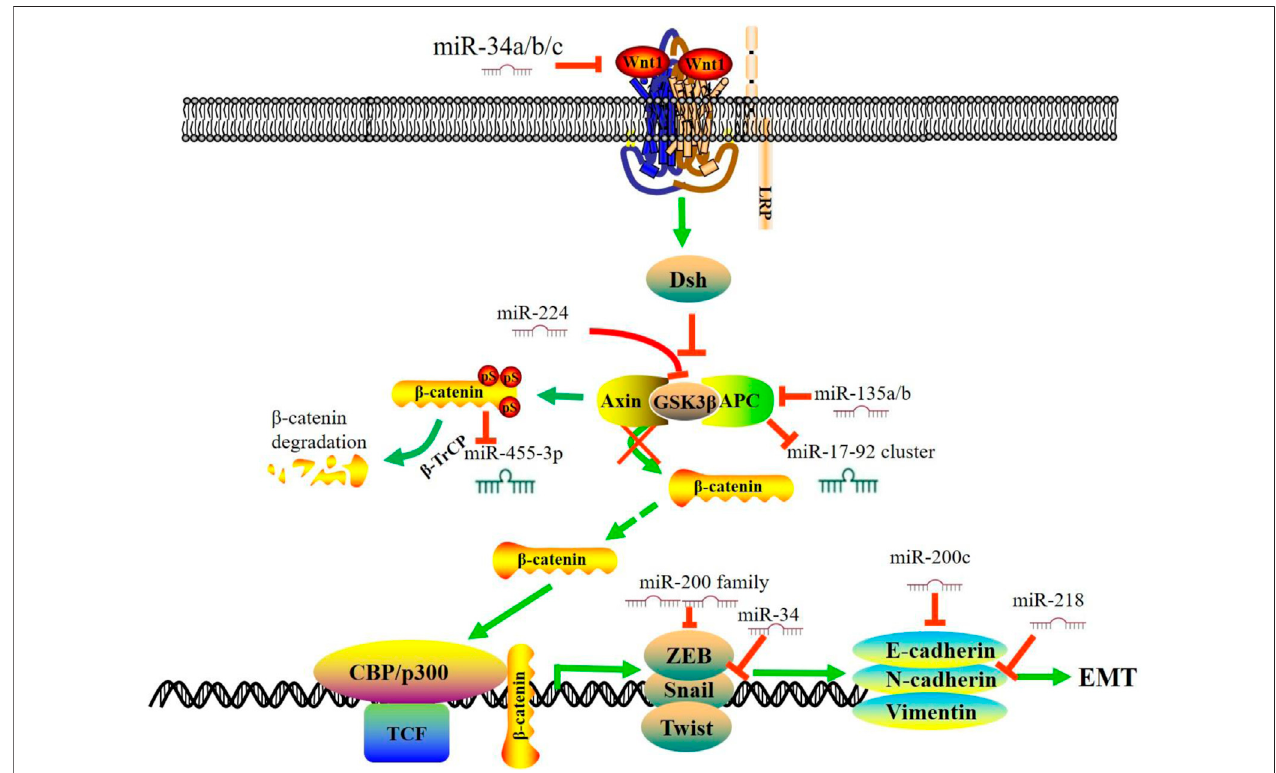
FIGURE1| MiRNAsregulateWnt/ β -catenin signalingpathway andEMTinCRC.IntheabsenceofWnt, β -catenin formsacomplexwithAPC,GSK3andAxin.The β -catenin isphosphorylatedbyGSK3 β andtargetedforubiquitin-dependentproteasomaldegradation. This fi guresummarizestheinteraction betweenmiRNAs andthe Wnt/ β -catenin signaling pathway in CRC and a subset of downstream miRNAs that are involved in the EMT process. During the process of EMT, the expression of mesenchymal markers, including N-cadherin and vimentin, is up-regulated, and the expression of the epithelial markers, including E-cadherin and ZO-1, is down- regulated. miR, microRNA; EMT, epithelial-to-mesenchymal transition; APC, Adenomatous Polyposis Coli; TCF, T-cell factor.